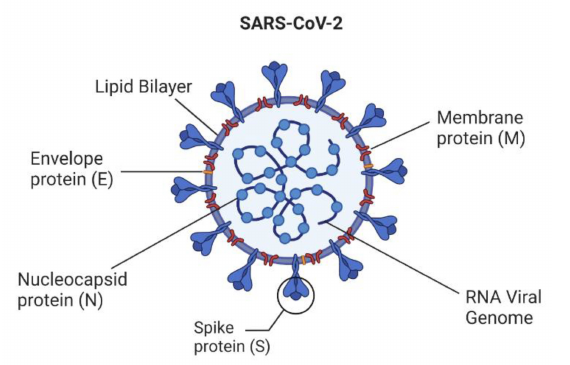
Figure 3. Schematic representation of various genomic parts and their organization in the SARS-CoV-2 viral